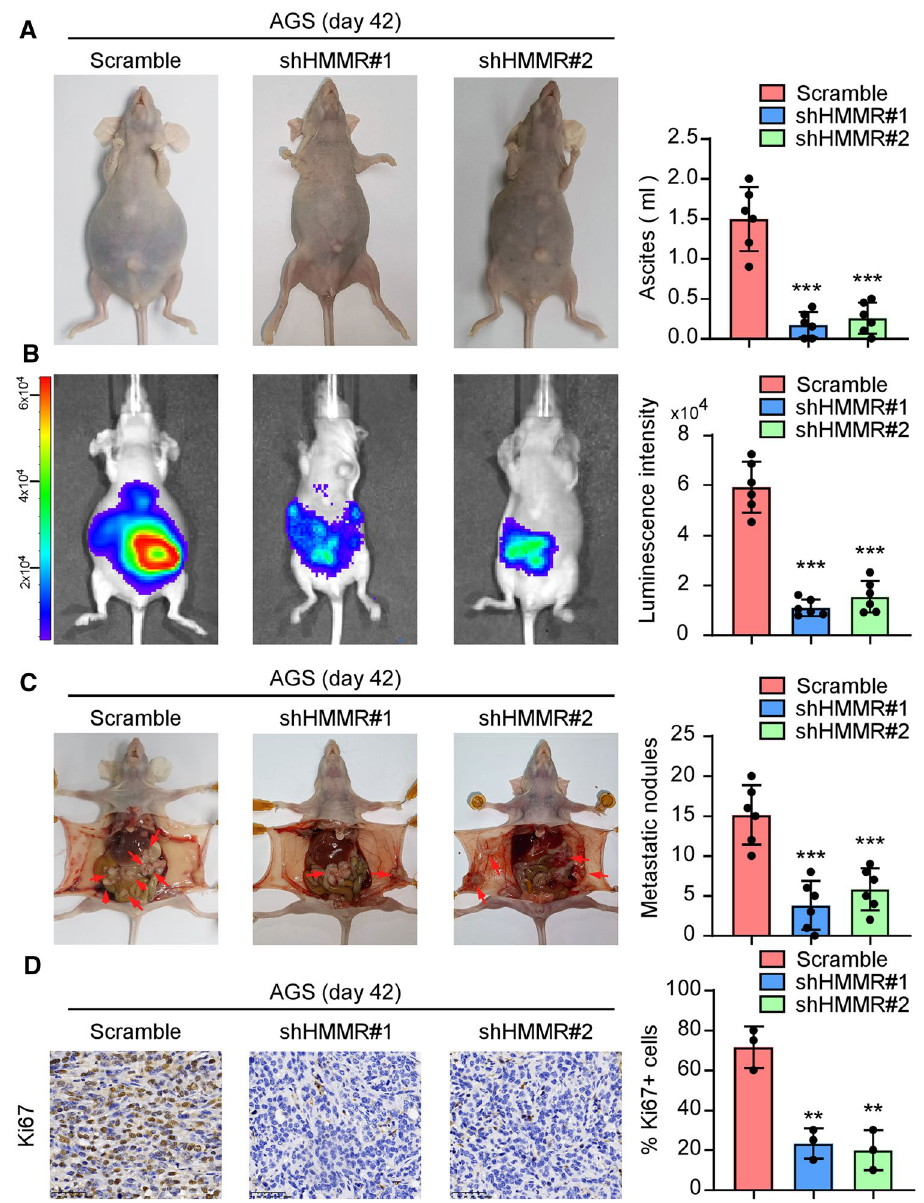
Fig. 2 HMMR knockdown diminished peritoneal implan- tation of gastric cancer. A 1 × 10 6 AGS cells with or without HMMR silencing were injected into the abdominal cavity of BALB/c-nu mice through middle flank (n = 6/ group). Bloody ascites were examined in the mice on day 42 after i.p. inoculation in indi- cated groups. B Luminescence intensity of abdominal cavity which represent distribution of the peritoneal dissemina- tion in indicated groups were shown. C Mice were killed for macroscopic examination to determine distribution of the peritoneal implantation. Silencing HMMR significantly reduced the tumor nodules in abdominal cavity. D Tumor nodules were obtained and IHC staining of Ki67 was per- formed in indicated groups. Each bar represents the mean ± SD of three independ- ent experiments. P < 0.05 was considered statistically